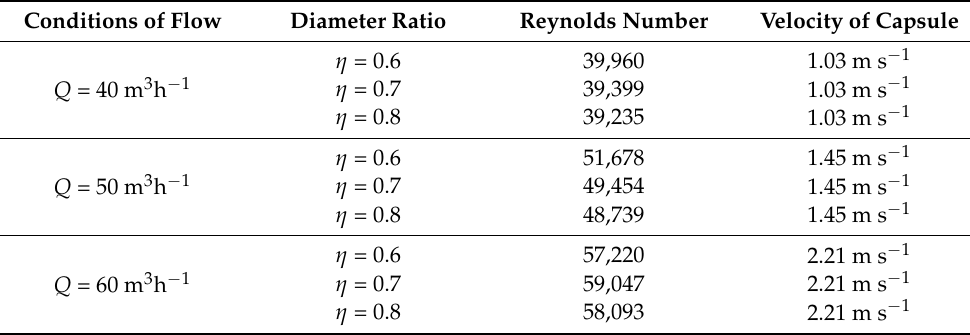
Table 2. Conditions of different flows and different diameter ratios. Conditions of